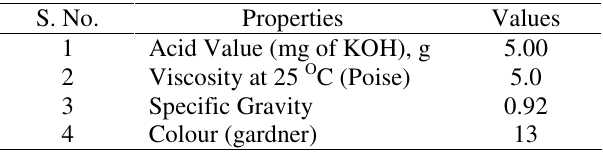
Table 1. Characteristics of HEJFA.